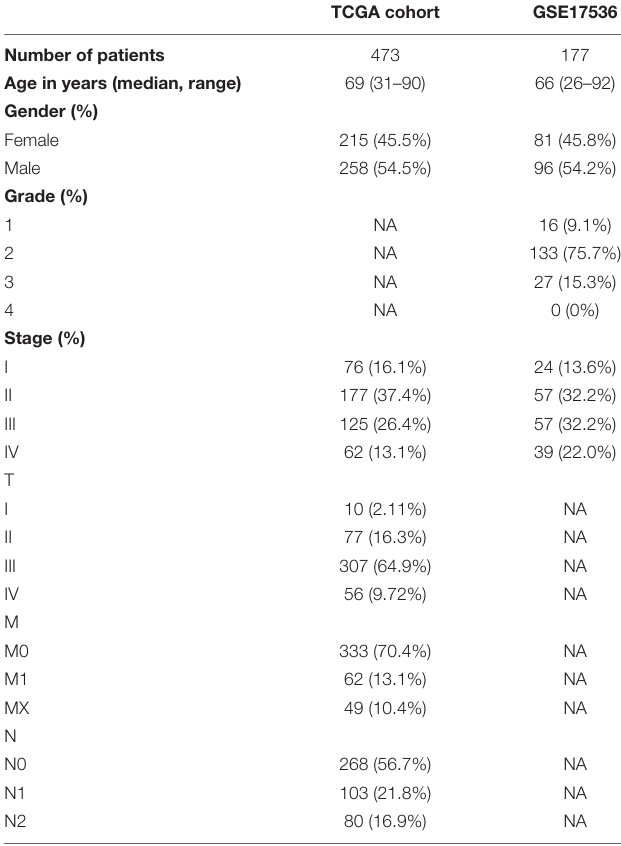
TABLE 1 | Clinical characteristics of the colon cancer patients used in this study. TCGA cohort GSE17536 Number of